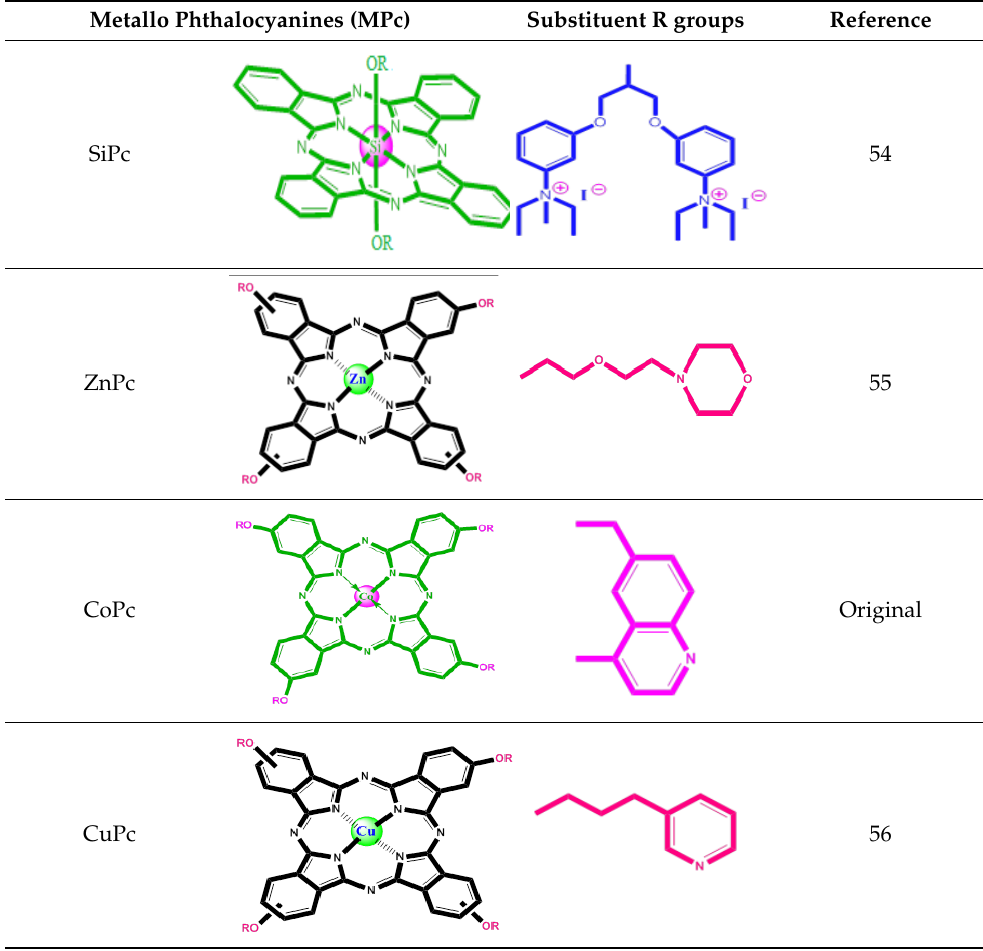
2 . Table 1. Pc molecules used in sensitization of TiO 2 .